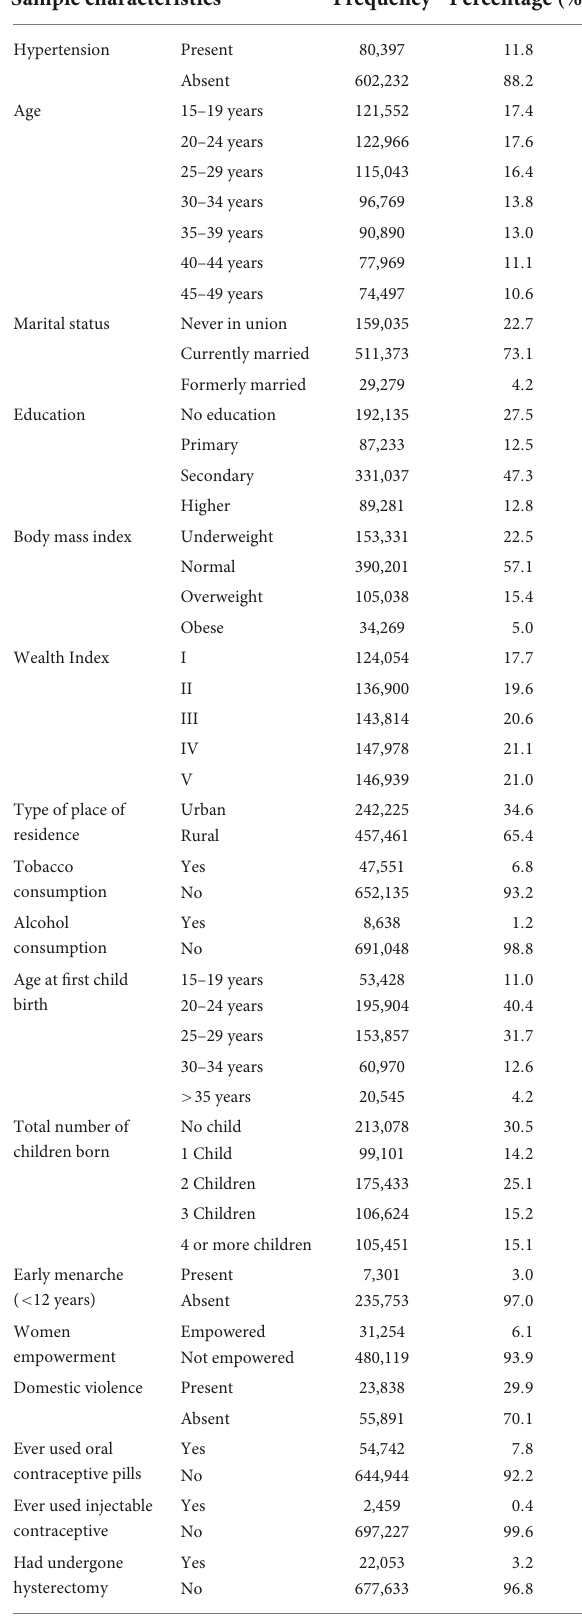
TABLE 1 Characteristics of women aged 15–49 years